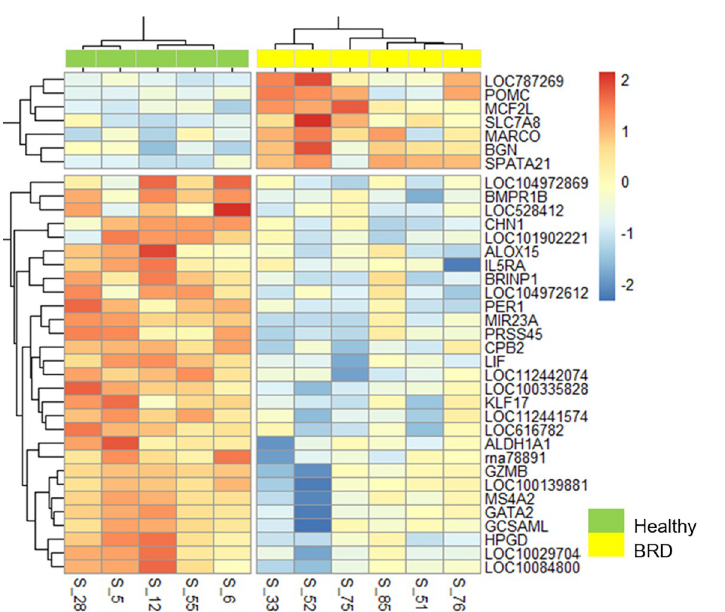
Fig 3. Heatmap of 36 differentially expressed genes identified at arrival between beef cattle that remained healthy and cattle that later developed BRD. Color scale (red-to-blue) represents gene expression levels per sample; red and blue colors indicate increased expression and decreased expression, respectively. Note that gene hierarchical clustering of gene expression profiles segregates BRD (yellow top panel) from healthy cattle (green top